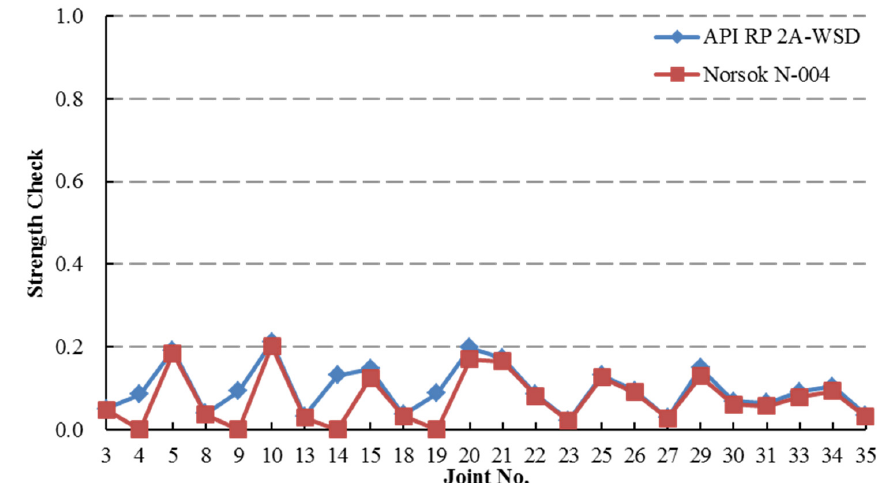
Figure 27. Joint Strength Check (Case 3).